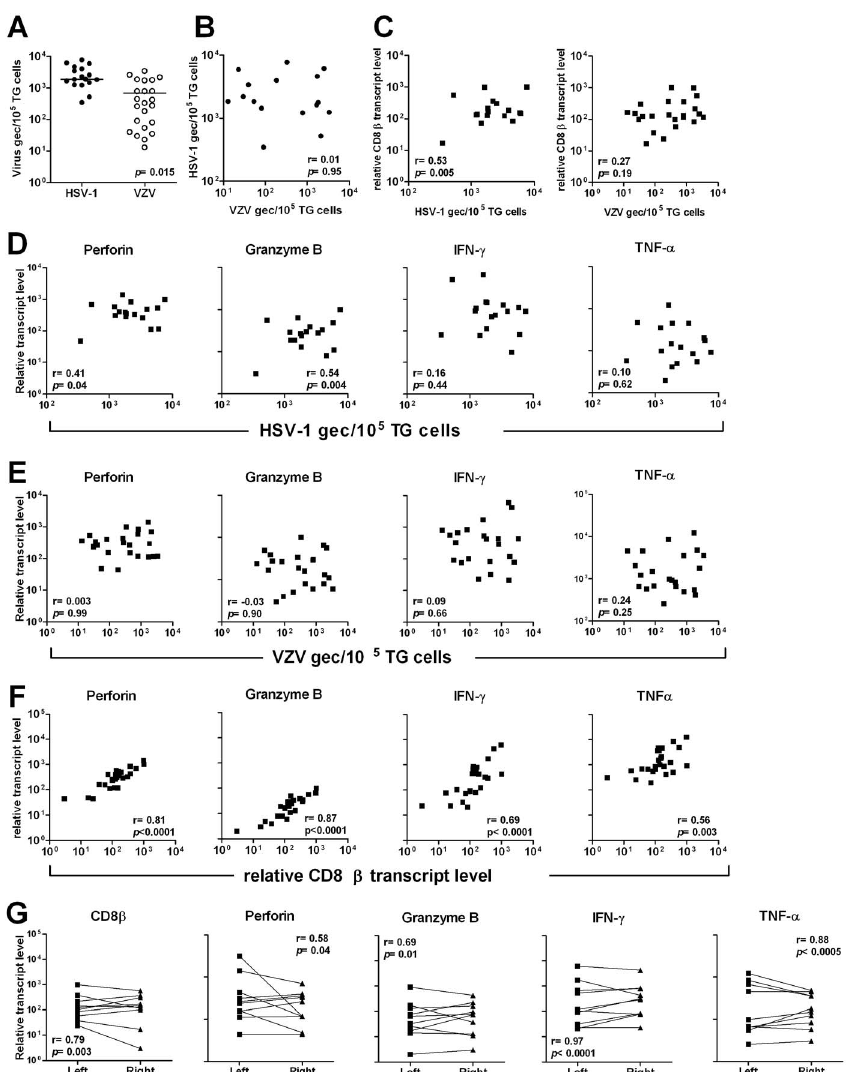
Figure 1. Comparison of T-cell cytolytic granule and cytokine transcripts to HSV-1 and VZV DNA load, and CD8 b transcript levels, in human TG. (A) Scatter plot showing the mean HSV-1 and VZV genome equivalent copies (gec) per 10 5 TG cells. (B) Comparison of HSV-1 and VZV DNA load in TG of individual donors. (C) Comparison between relative CD8 b transcript levels and HSV-1 and VZV DNA load. (D) Comparison of HSV-1 DNA load with relative transcript levels of perforin, granzyme B (grB), interferon c (IFN- c ) and tumor necrosis factor a (TNF- a ). (E) Comparison of VZV DNA load with relative transcript levels of perforin, grB, IFN- c and TNF- a . (F) Comparison between relative CD8 b transcript levels and perforin, granzyme B, IFN- c and TNF- a . (G) Comparison of the transcript levels of CD8 b , perforin, grB, IFN- c and TNF- a between paired left and right TG of individual donors. The paired T -test (A), Spearman correlation (B–F) and Wilcoxon matched pairs test (G) were used for statistical analysis. Data of 26 TG specimens